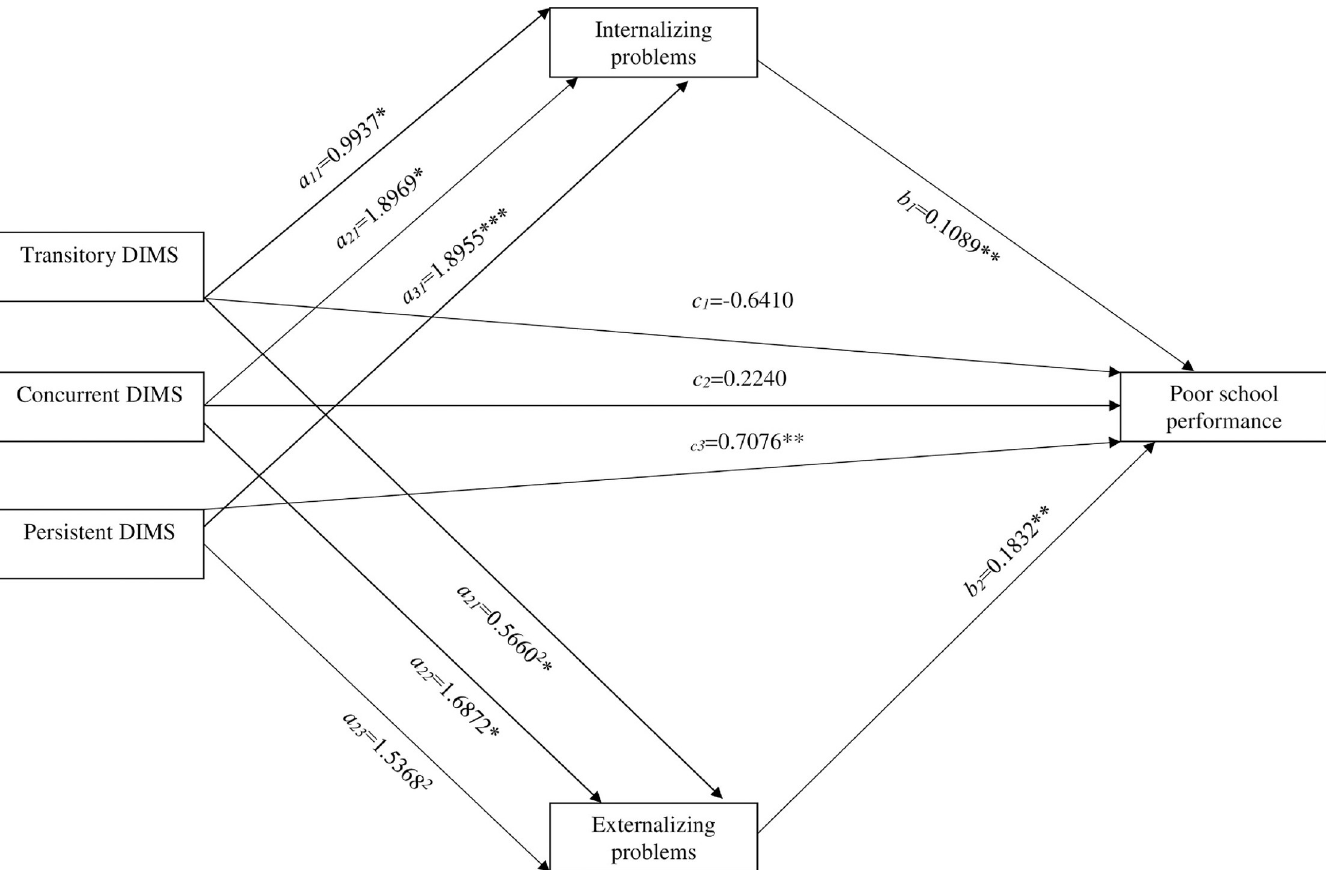
Fig 1. Parallel multiple mediator model between antecedent DIMS and school performance. Fig 1 represents a graphic depiction of the odds ratio reflecting in a parallel multiple mediator model with two mediators (Internalizing problems and externalizing problems) between the multi-categorical antecedent DIMS groups (with the No DIMS-group as the reference) and Poor school performance. The a11-13 paths depict the relative direct effects in terms of Ordinary Least Squares Linear (OLS) ), the Concurrent DIMS ( ) and the Persistent ( ) DIMS groups (with the No DIMS group as reference) on the regression coefficients of the Transitory DIMS ( a11 a21 a31 mediators Internalizing problems. The a21-23 paths depict the relative direct effects in terms of OLS regression coefficients of the Transitory DIMS ( a21 ), the Concurrent DIMS ( a22 ) and the Persistent ( a32 ) DIMS groups (with the No DIMS group as reference) on the mediator Externalizing problems.The b1-2 paths depict the relative (to the No DIMS group) indirect effects in terms of OLS regression coefficients reflecting the three relative paths for the effect of DIMS on poor school performance through DIMS’ effect multiplied by the three groups (relative to the No DIMS group as reference through DIMS’ effect on Internalizing ( b1 ) and Externalizing ( b2 ) problems. The paths reflecting the relative direct effects in terms of OLS regression coefficients for the Transitory DIMS ( , the Concurrent DIMS ( and the c1-3 c1 ) c2 ) Persistent DIMS ( c3 ) groups (with the No DIMS group as